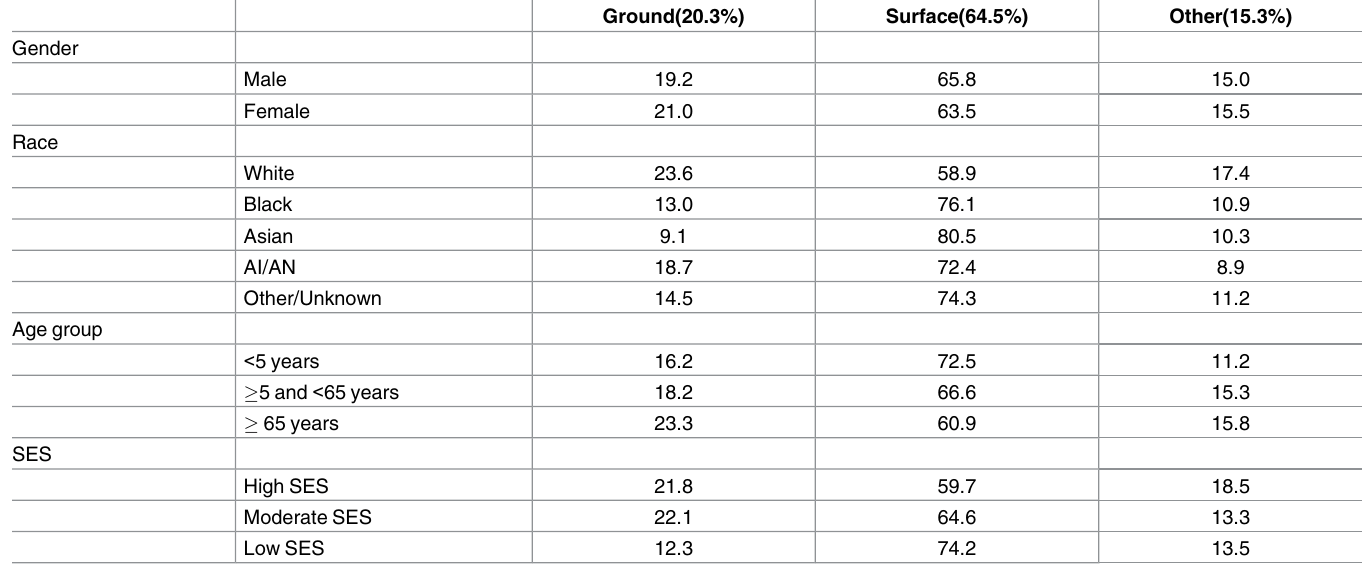
Table 1. Percentage of cases by gender, race, age group, and SES demographic characteristics by water source type.